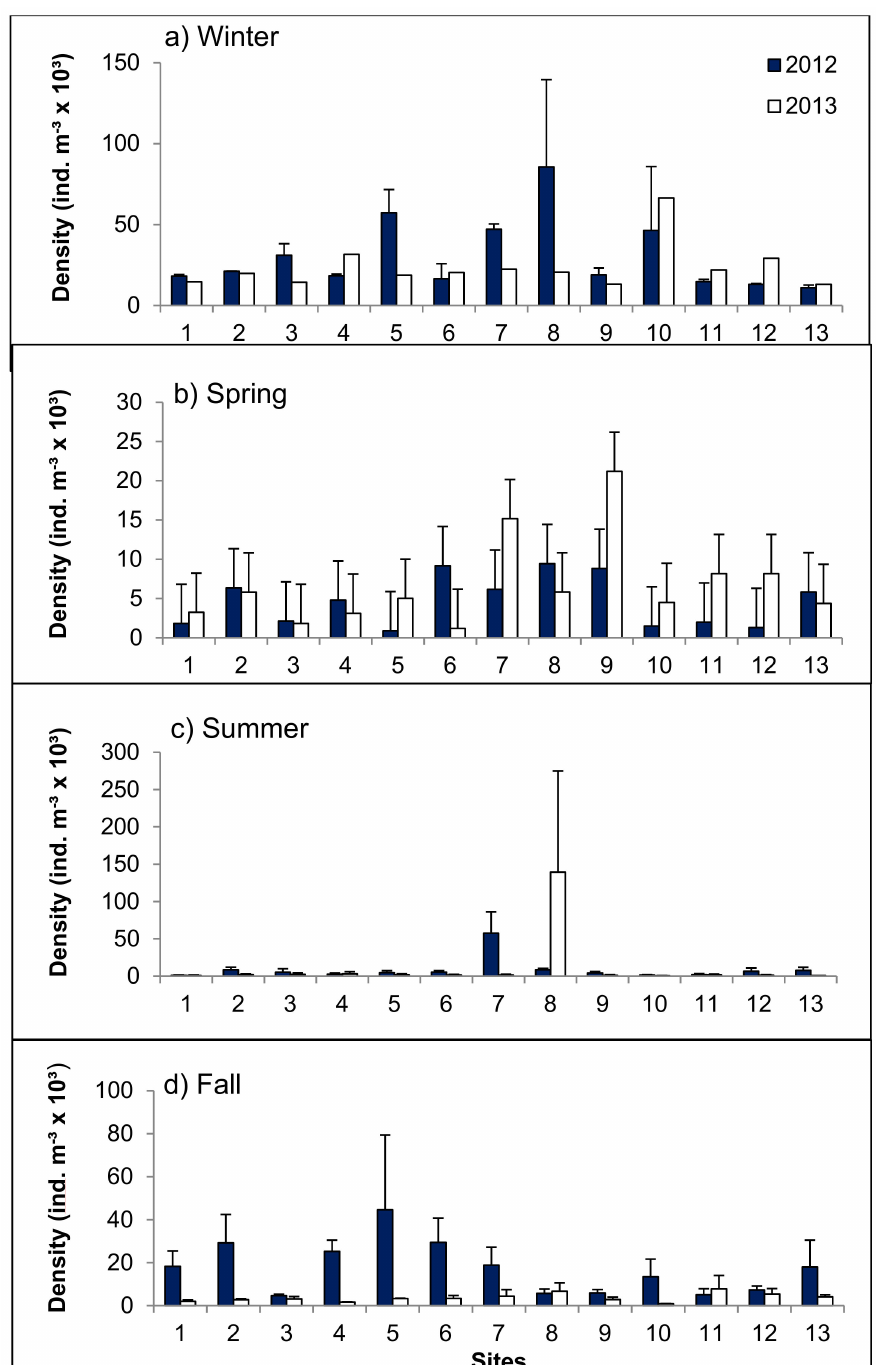
Figure 4. Spatial patterns in the densities ( + SE) of mesozooplankton in the Maryland Coastal Bays in 2012 (year of below average freshwater discharge) and 2013 (year of above average freshwater discharge): ( a ) winter; ( b ) spring; ( c ) summer; and ( d )